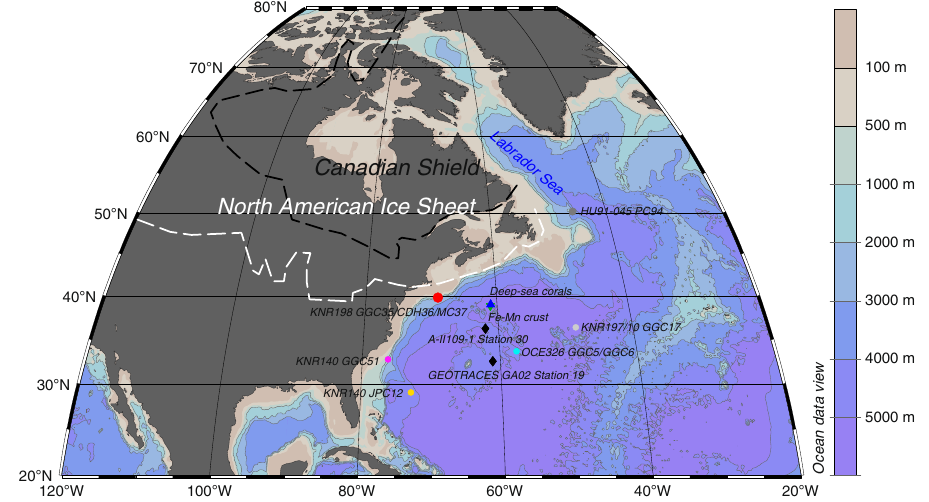
Fig. 1 North Atlantic sites and bathymetry. Sediment cores (dots): KNR198-GGC35/CDH36/MC37 (40°N, 69°W, 1820 m; this study), KNR140-GGC51 (1790 m) and JPC12 (4250 m) 17,36 , OCE326-GGC5/GGC6 (4550 m) 2,32 , KNR197/10-GGC17 (5010 m) 49 and HU91-045-PC94 (3450 m) 64 ; Deep-sea corals (1180 – 1380 m; triangle) 33 ; Ferromanganese crust BM1969.05 (1800 m; inverted triangle) 13 ; Seawater samples (diamonds): A-II109-1 Station 30 10 and GEOTRACES-GA02 Station 19 11 . Black and white dash lines delineate the boundary of the Canadian Shield and the maximum extent of the North American ice sheet during the LGM, respectively 34 . Figure made with Ocean Data View 71